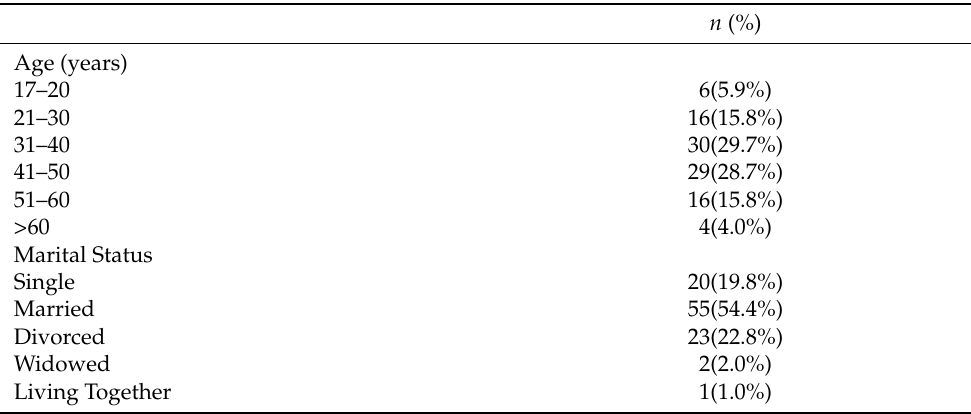
Table 1. Demographic characteristics of inmates ( n =